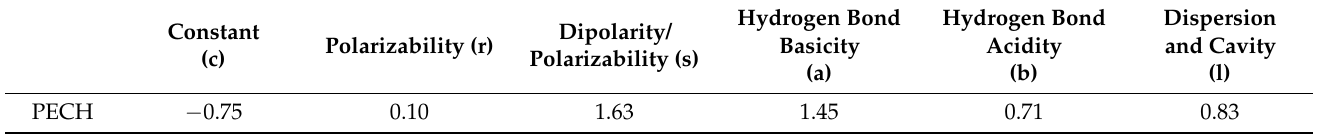
Table 2. LSER coefficients of poly(epichlorohydrin) (PECH) determined at temperature of 25 °C.